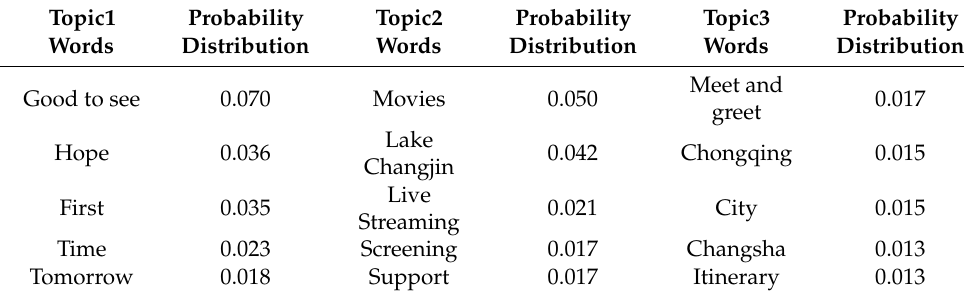
Table 14. B2 LDA theme model